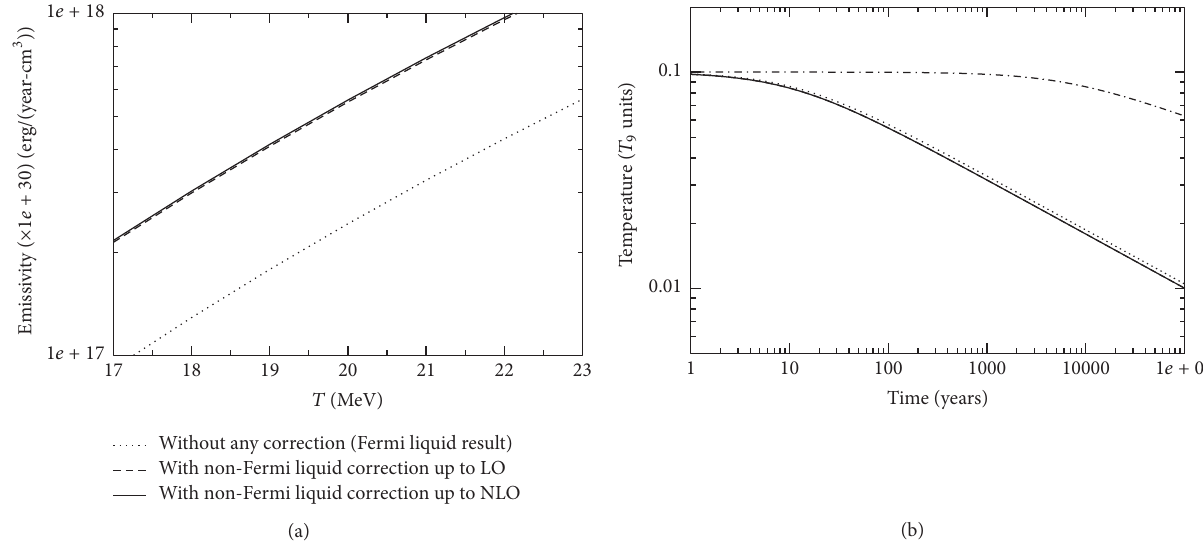
Figure3:Theemissivityoftheneutrinoswithtemperatureindegeneratequarkmatter( 𝑇 9 inunitsof 10 9 K)hasbeenshownin(a).Thecooling behavior of neutron star with core as neutron matter and degenerate quark matter has been presented in (b). The dotted line represents the FL result, and the solid line depicts the NFL NLO correction. The dash-dotted line gives the cooling behavior of the neutron star core made up of purely neutron